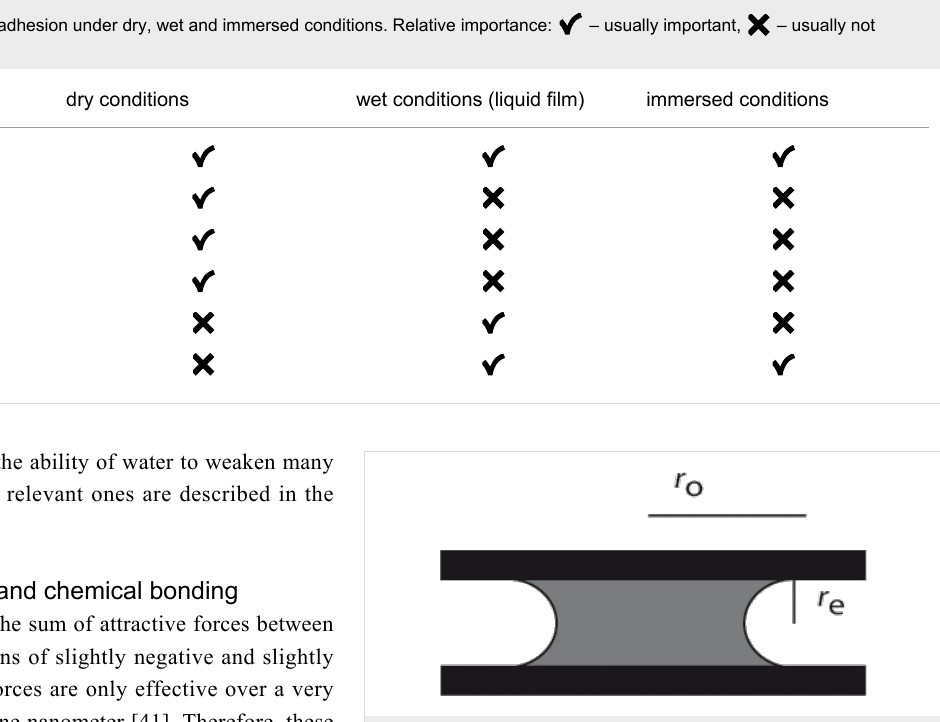
Figure 4: Two hydrophilic surfaces separated by water. Graph shows the location of the overall radius ( r o ) of the wetted surface and the radius of the curved edge ( r e ). The latter is half the thickness of the